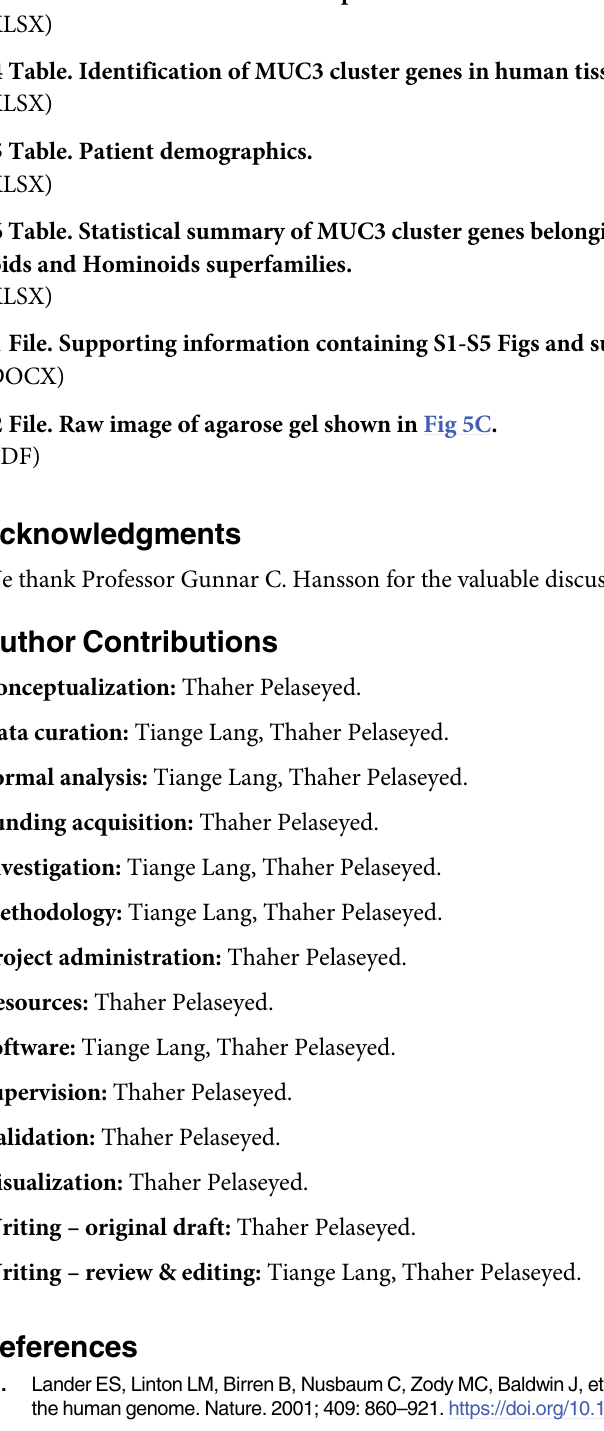
S2 Table. Conservation of N-terminal, PTS, and C-terminal regions of MUC3 cluster genes in primates. S3 Table. Binding sites upstream of the MUC3A gene transcription start site for transcrip- tion factors enriched in intestinal epithelial cells. S4 Table. Identification of MUC3 cluster genes in human tissues. S5 Table. Patient demographics. S6 Table. Statistical summary of MUC3 cluster genes belonging to members of Cercopithe- coids and Hominoids